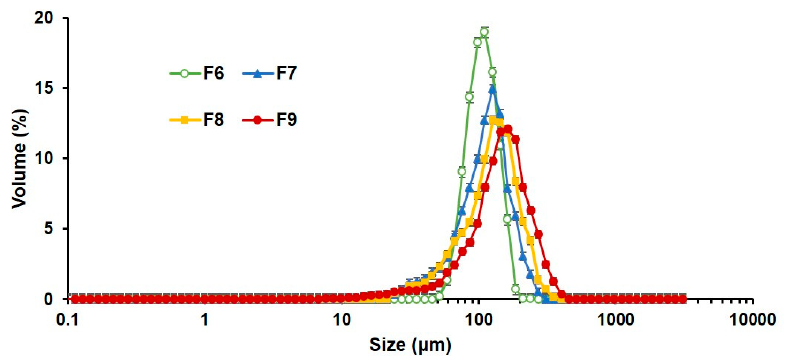
Figure 4. Particle size distribution of PLGA MS F6 to F9 (mean ± SD, n = 3). PLGA, poly(lactide- co -glycolide); MS, microspheres.